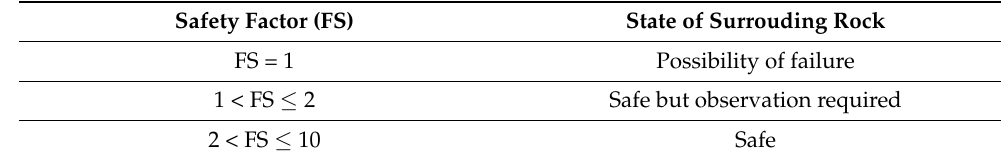
Figure 8. Definition of the safety factor. Table 3. State range of the surrounding rock according to the safety factor. Table 3. State range of the surrounding rock according to the safety